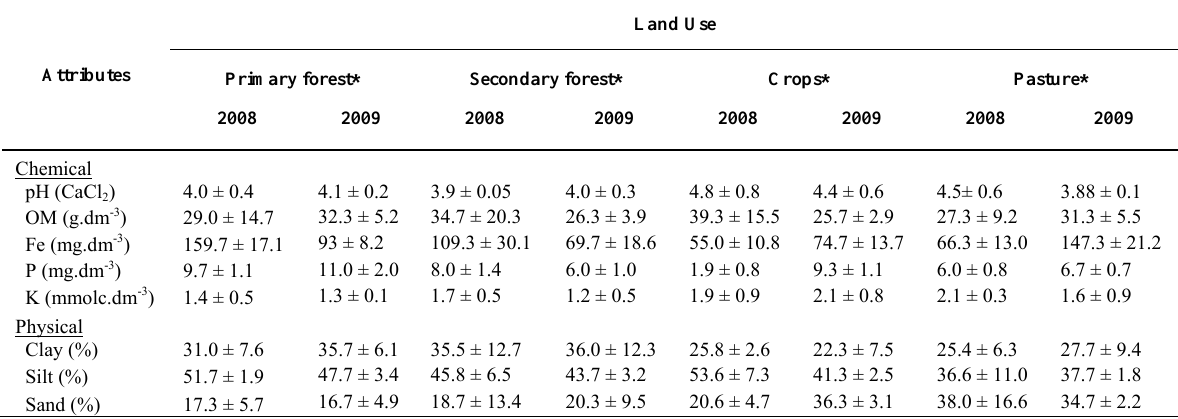
Table 1. Chemical and physical attributes of soil samples from different land use systems in Benjamin Constant